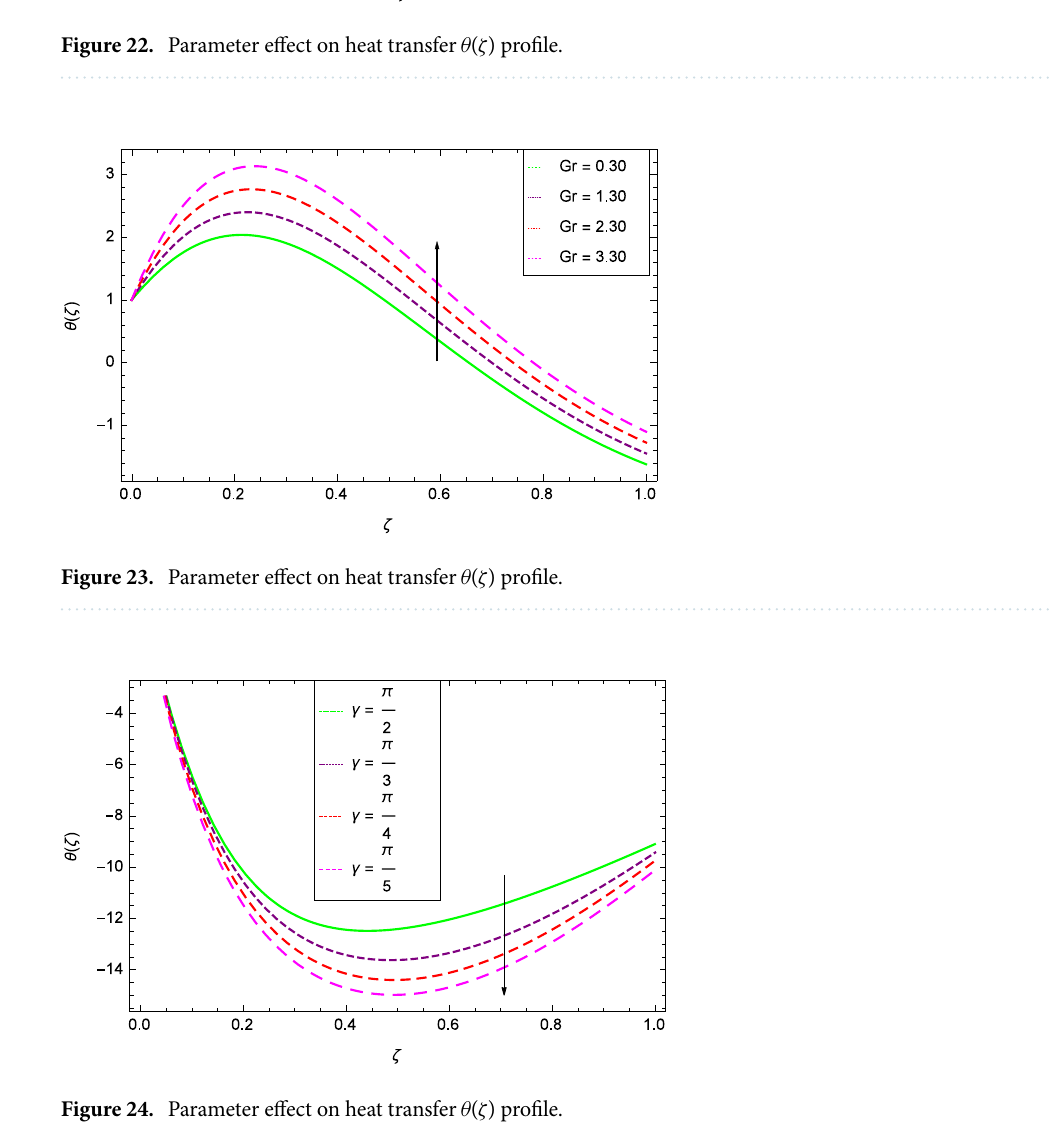
Figure 24. Parameter effect on heat transfer θ ( ζ )